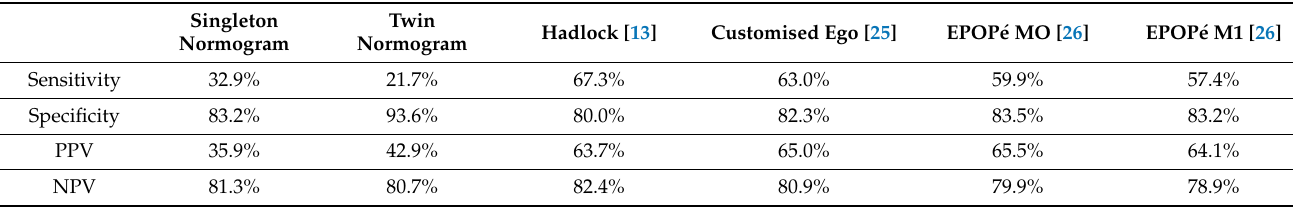
Table 4. Comparison of sensitivity, specificity, and positive and negative predictive values of selected charts in detection of SGA